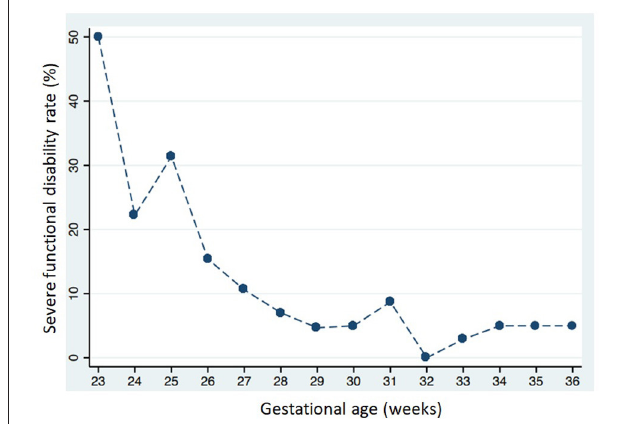
FIGURE 4 | Severe functional disability in relation to gestational age at